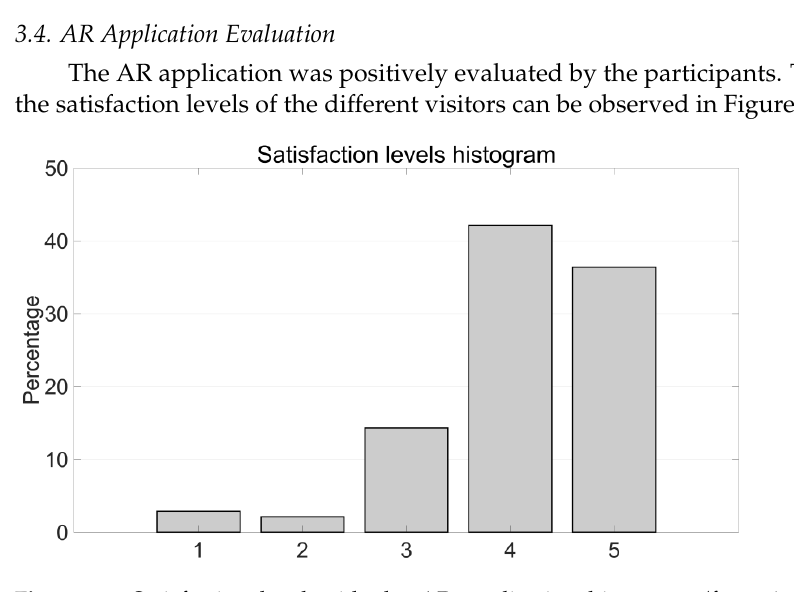
Figure 8. Satisfaction level with the AR application histogram (from 1—poorly satisfied to 5—very